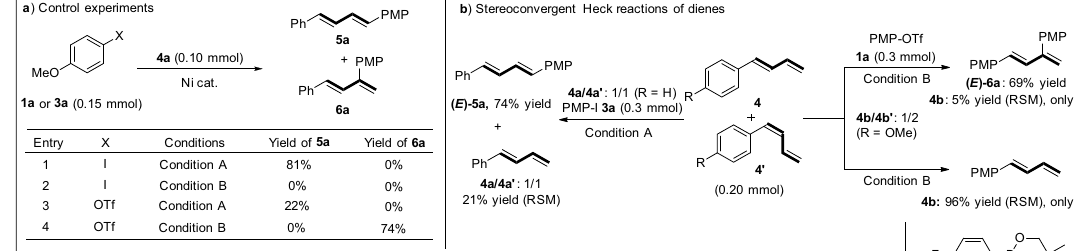
Fig. 4 | Mechanistic studies of Heck reactions. a Control experiments. b StereoconvergentHeckreactionsofdienes. c Theeffectofligands. d Thecapture